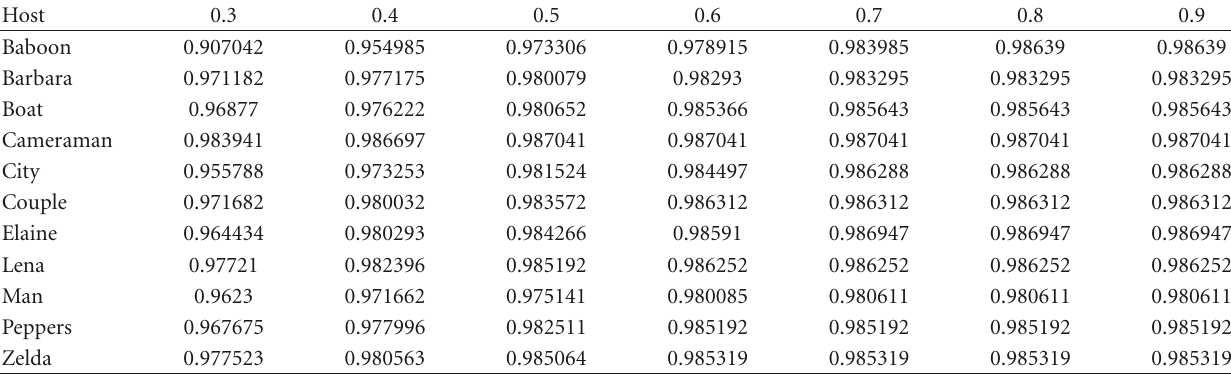
Table 4: Normalized correlation coe ffi cients after JPEG2000 compression on watermarked images in which the watermark is embedded in the highest frequency subband.